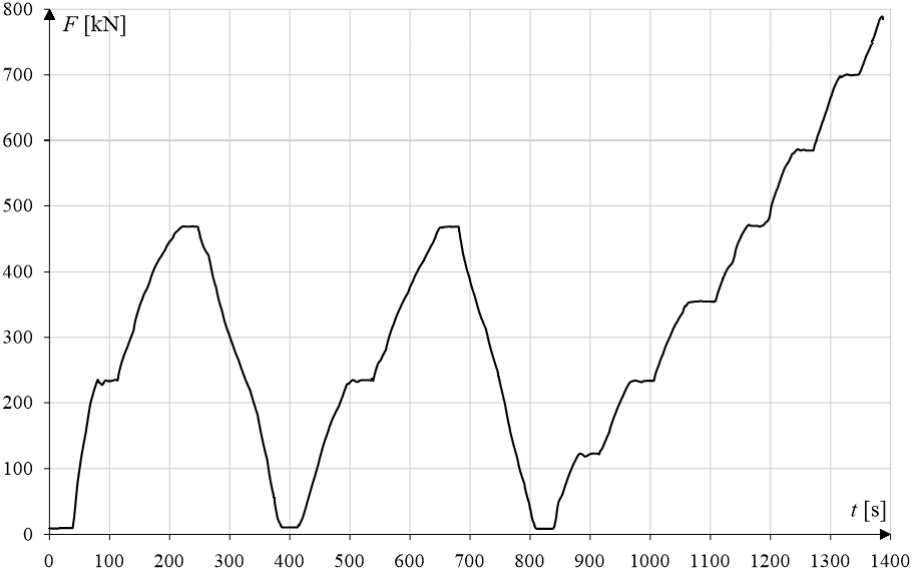
Figure 10: Diagram of specimen loading according to method